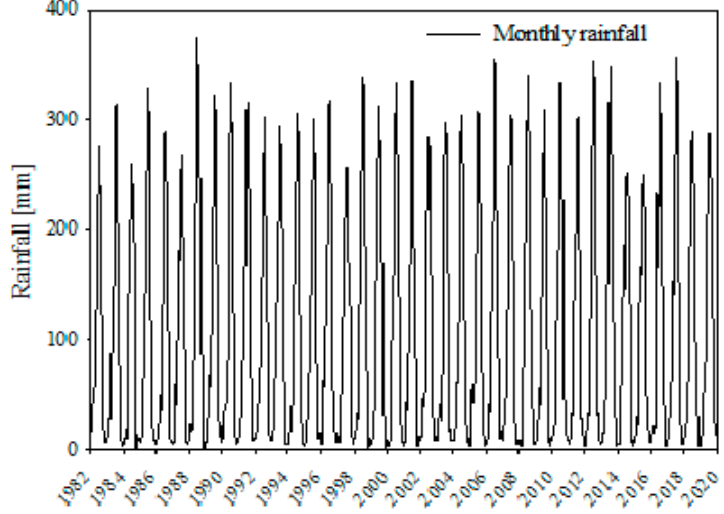
Figure A1. Rainfall. Figure A1.